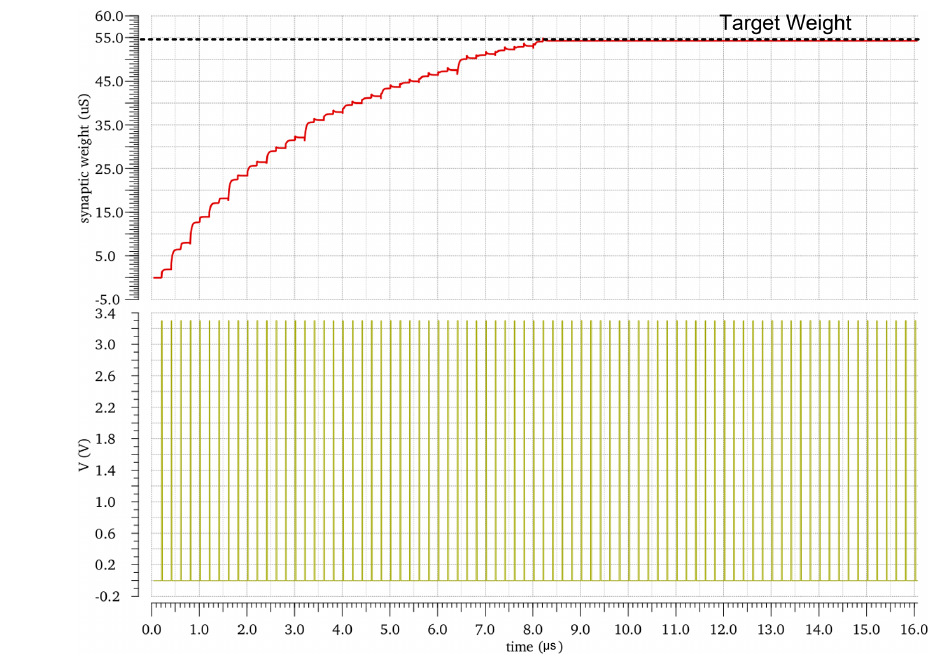
Figure 30. Target weight at V RFR equal to 600mV, vg1 and vg2 equal to 1V, and V LEAK equal to 700mV. Circuit conditions are V dd of 3 . 3V, and temperature equals 27 ◦ C and on the nominal